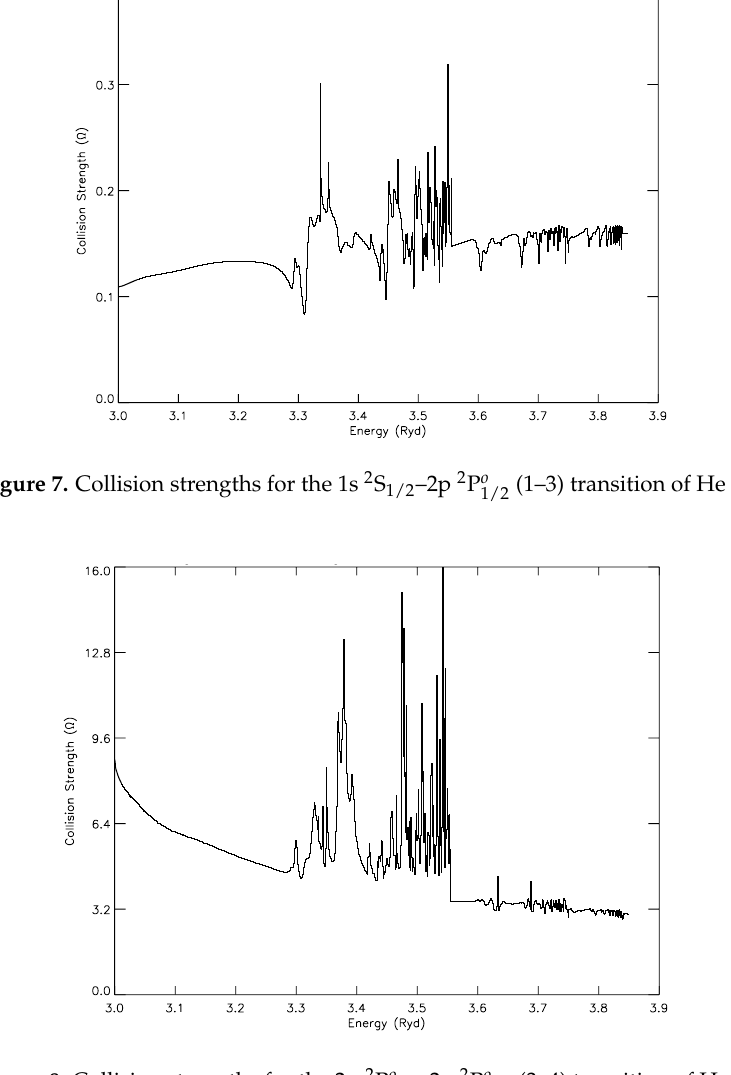
–2p 2 P o (3–4) transition of He 1/2 3/2